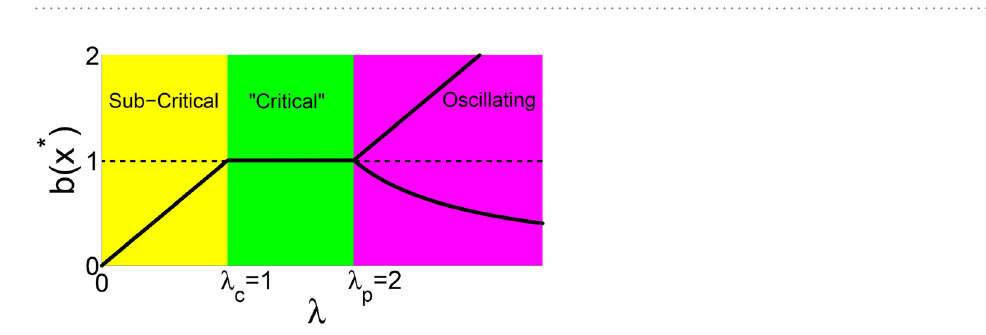
Figure 1. Activity dependent branching ratio for different parameter regimes of ( a ) λ < 1, ( b ) 1 < λ < 2, ( c ) λ = 2 and ( d ) λ > 2.